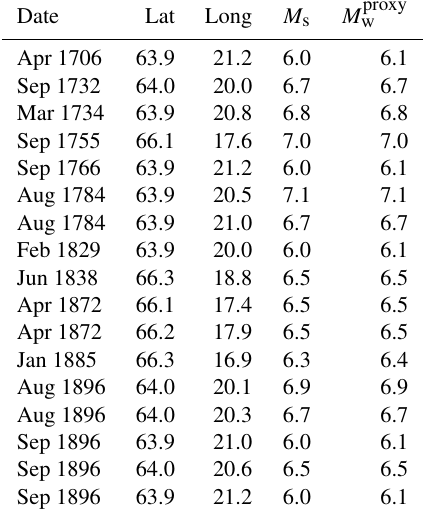
Table 2. Historical large earthquakes in Iceland in the 18th and 19th centuries. The magnitude estimates are based on the resulting damage (Halldórsson, 1992b; Stefánsson et al., 2008; Sólnes et al., 2013). The epicentral locations are approximate, but overall the lon- gitude is more accurate than the latitude since in most cases N–S surface faults have been mapped and linked to the largest events. Note that these earthquakes are not included in the new